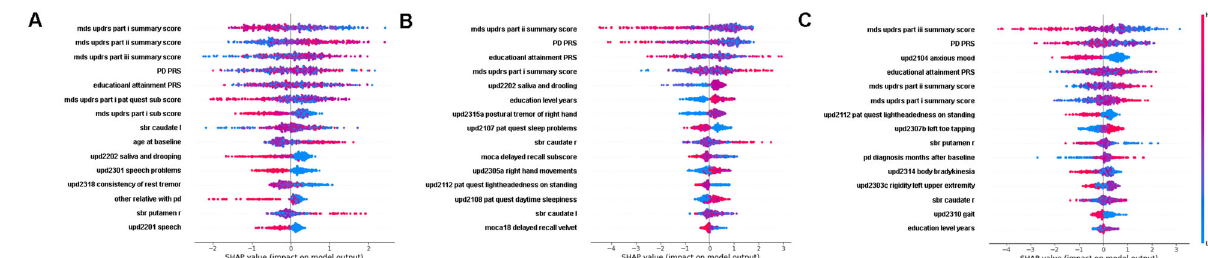
Fig. 2 12-month MDS-UPDRS subpart and Total predictive feature importance. Shapley feature importance plots for 12-month MDS-UPDRS I ( A ), II ( B ), and III ( C ) subpart progression prediction. Features are ranked for most to least important (top to bottom). Coloration depicts the value for each feature (red = high values, purple = average values, blue = low values). The impact on prediction at the individual-level is indicated by the points, where points to the right indicate increased importance for prediction of progressor status, and points to the left indicate increased importance for the prediction of non-progressor status. See Fig. 3B for the Shapley plot for MDS-UPDRS Total progression